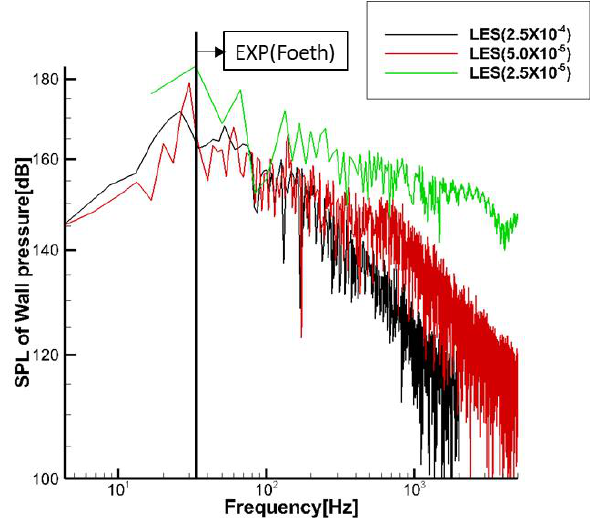
Figure 12. SPL of wall pressure using LES model according to time step. Table 9. SPL 1 and SPL of wall pressure using LES model according to time steps and turbulence model at probe 6.